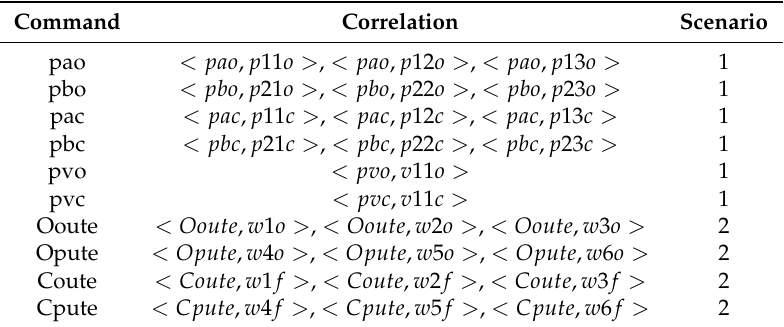
Table 3. Correlations between commands and executed